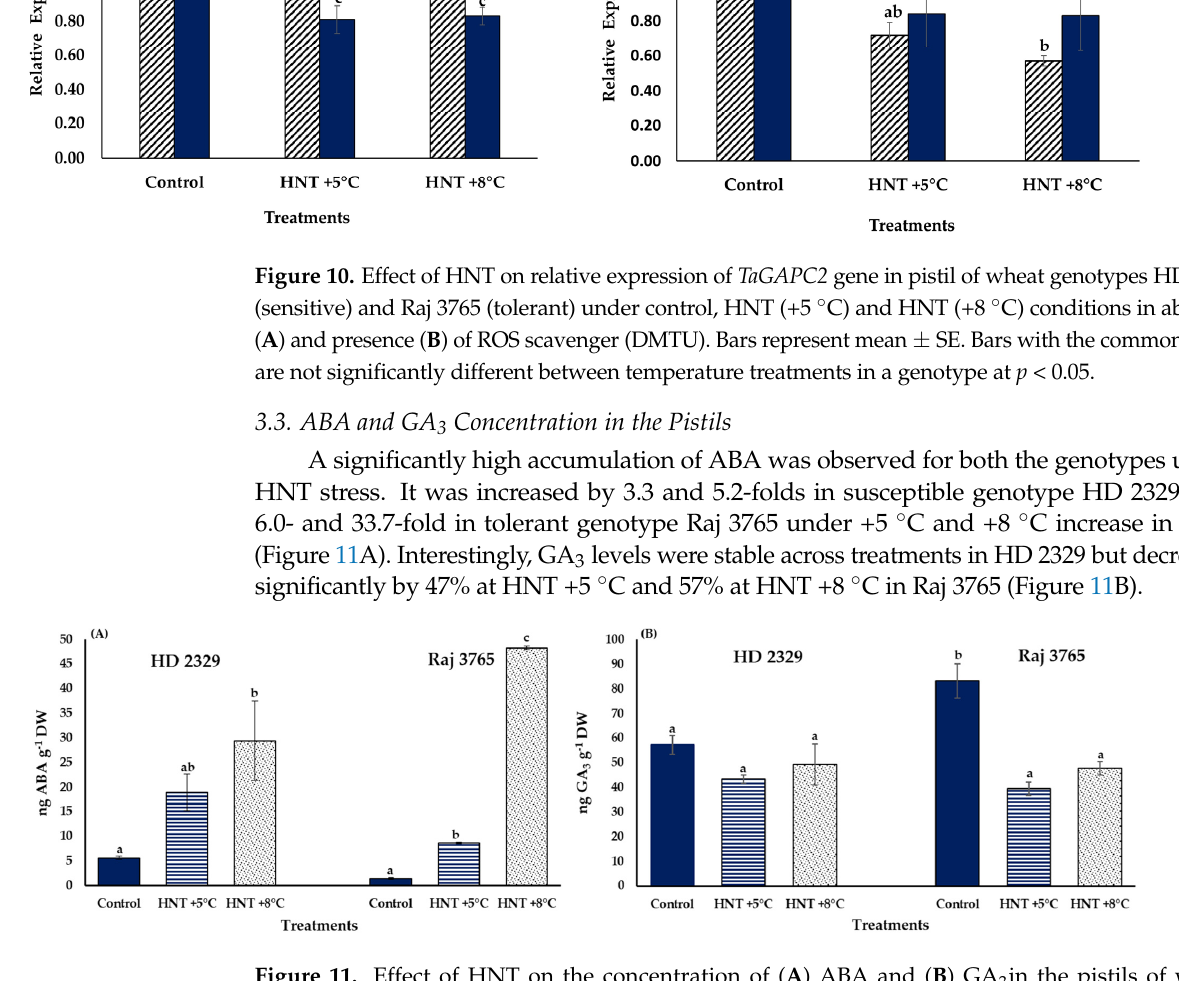
Figure 9. Effect of HNT on GAPC activity in pistil of wheat genotypes ( A ) HD 2329 (sensitive) and ( B ) Raj 3765 (tolerant) under control, HNT (+5 °C) and HNT (+8 °C) conditions in absence and pres- ence of ROS scavenger (DMTU). Bars represent mean ± SE. Bars with common letter are not signif- icantly different between temperature treatments in a genotype at p < 0.05.